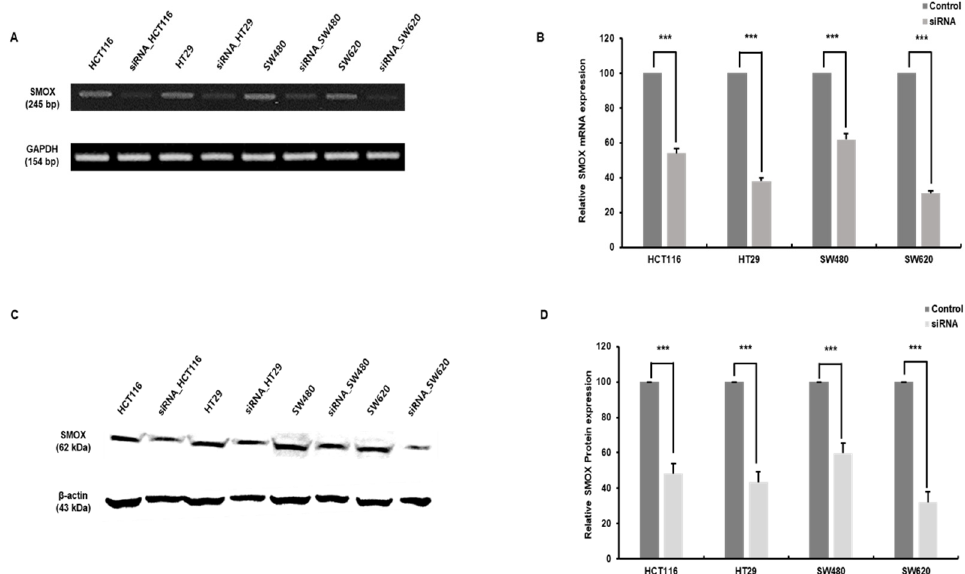
Figure 1. Expression of SMOX in colorectal cancer (CRC) cell lines and the effects of SMOX siRNA (small interfering RNA). SMOX expression and inhibition were confirmed by RT-PCR and immunoblot. ( A ) Screening by RT-PCR of SMOX in CRC cell lines and confirmation of SMOX inhibition compared with control cells. ( B ) Relative RNA expression of SMOX. The expression of SMOX siRNA-transfected cell lines was significantly lower than that in the control cell lines (*** p < 0.001). ( C ) Expression levels of SMOX and β -actin were determined by Western blotting in CRC cell lines. ( D ) Relative protein levels of SMOX. SMOX siRNA-transfected cell expression levels were lower than those in the control (*** p < 0.001).